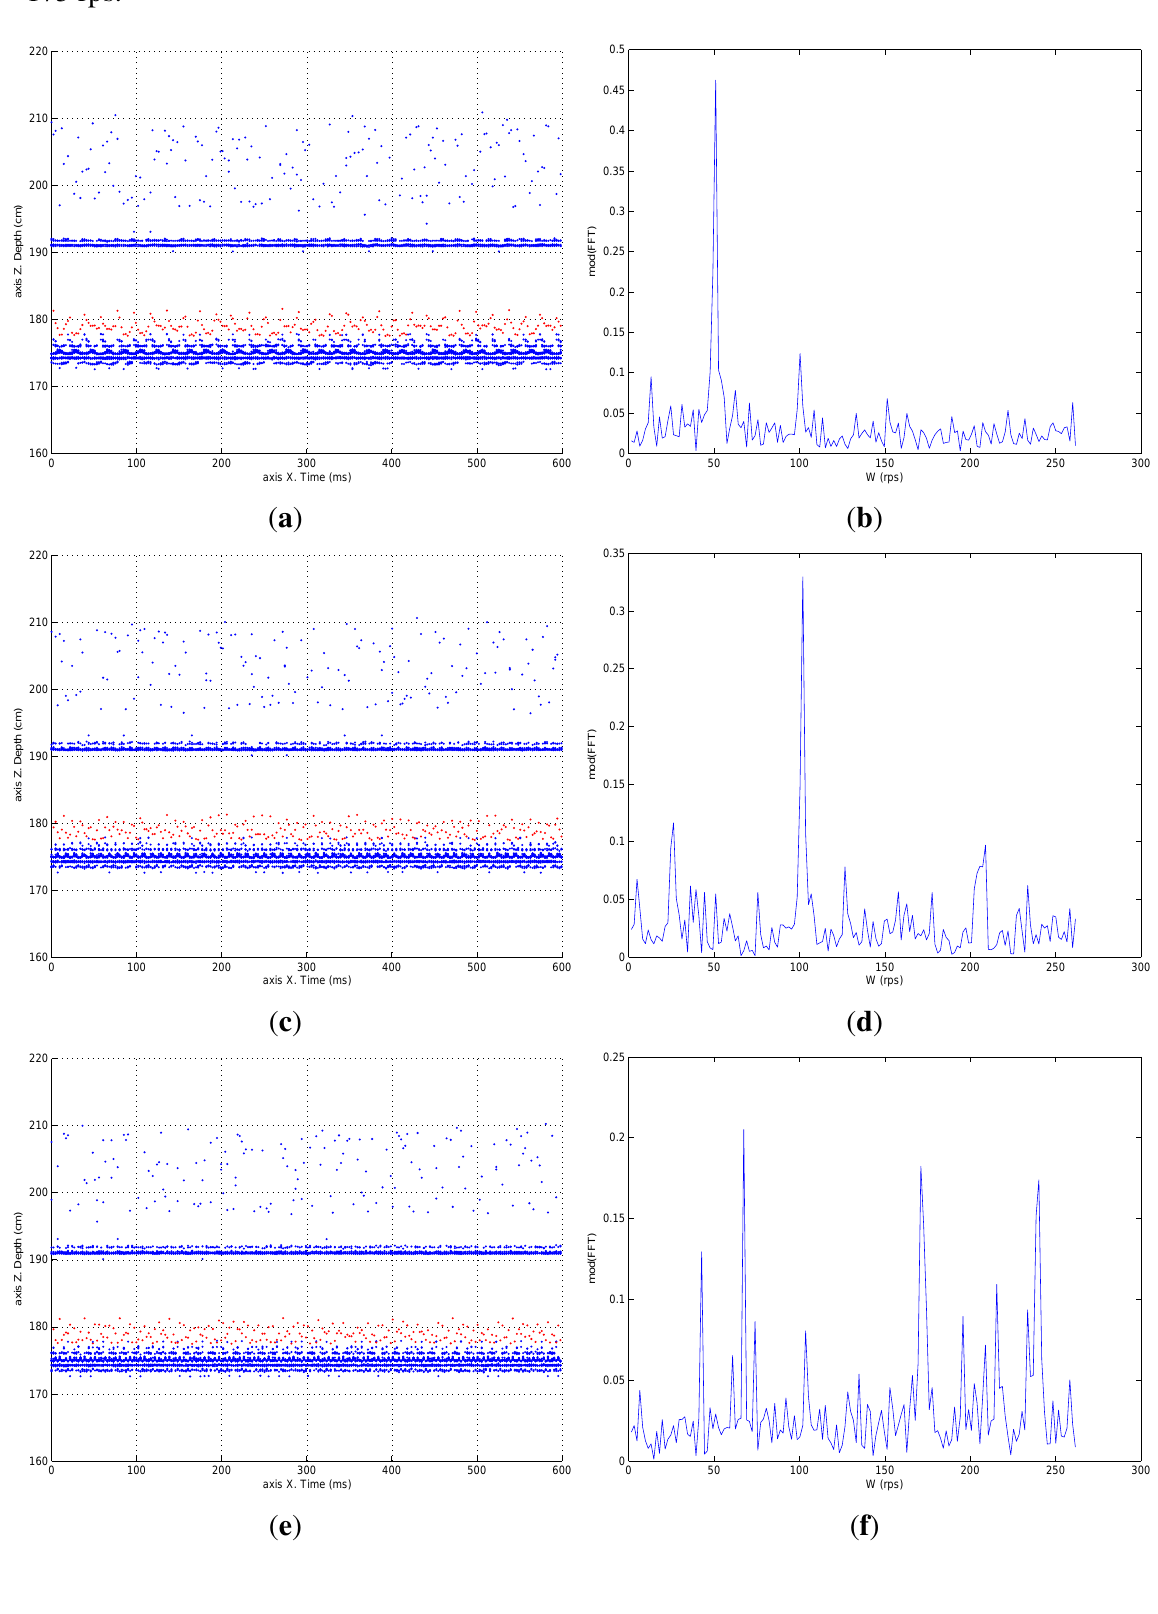
Figure 10. Depth map and average oscillation for 50, 100 and 175 rps helix movement. Classical